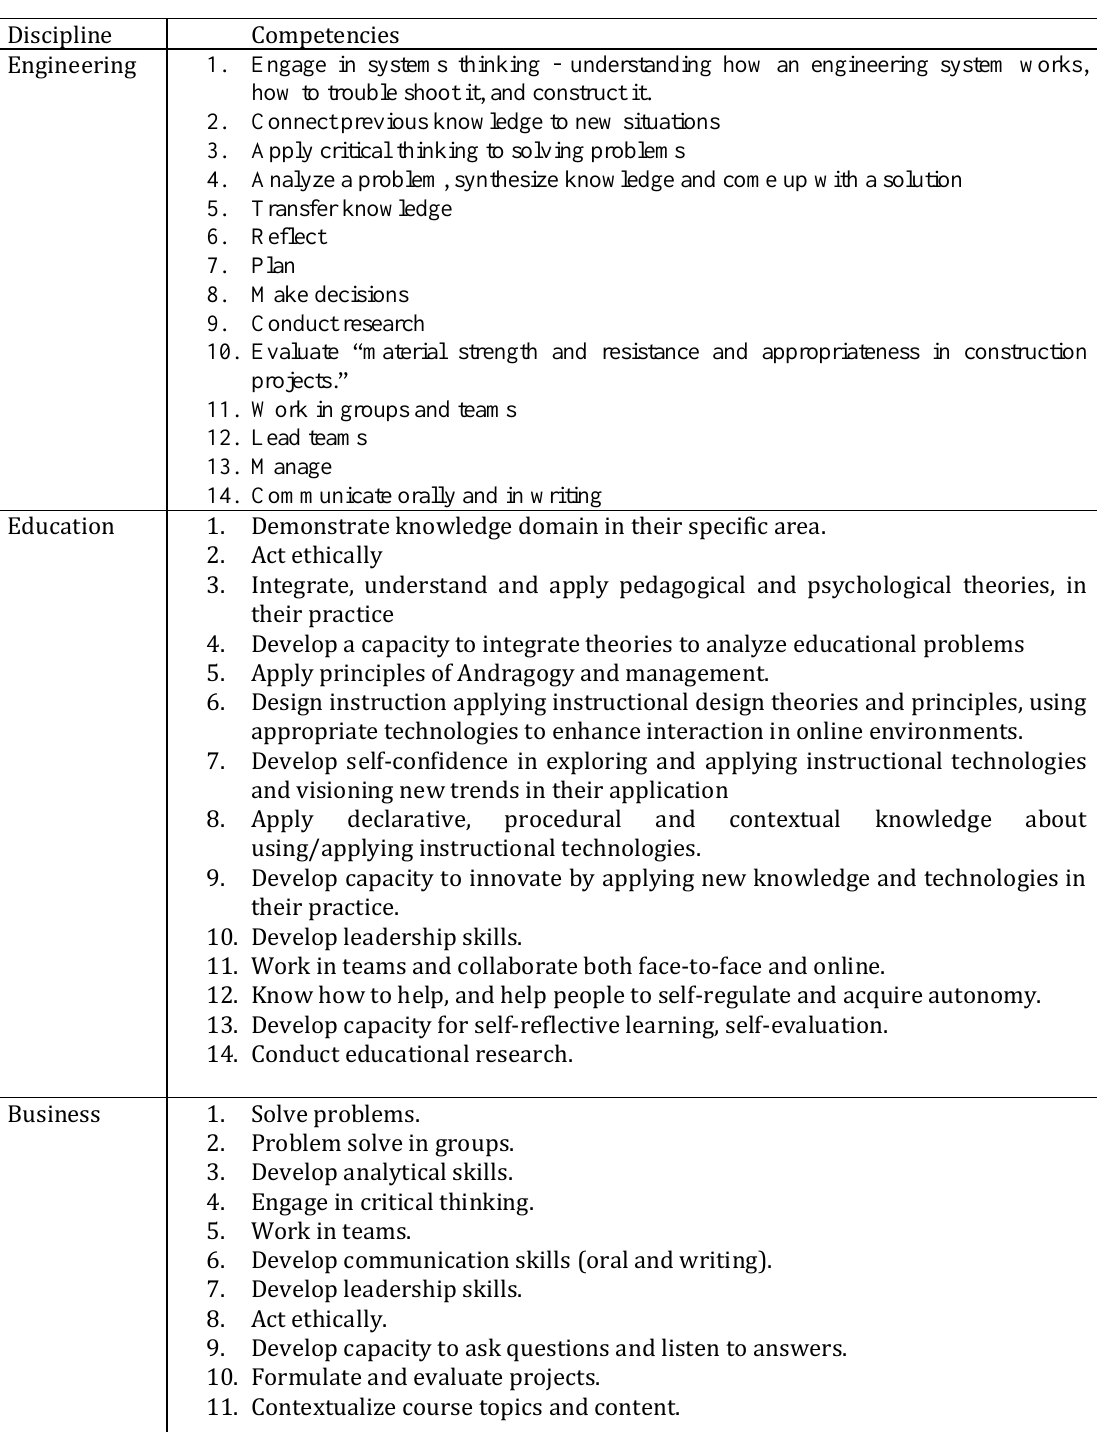
Table 1 Summary of Competencies for the Three Disciplines by the Three Countries